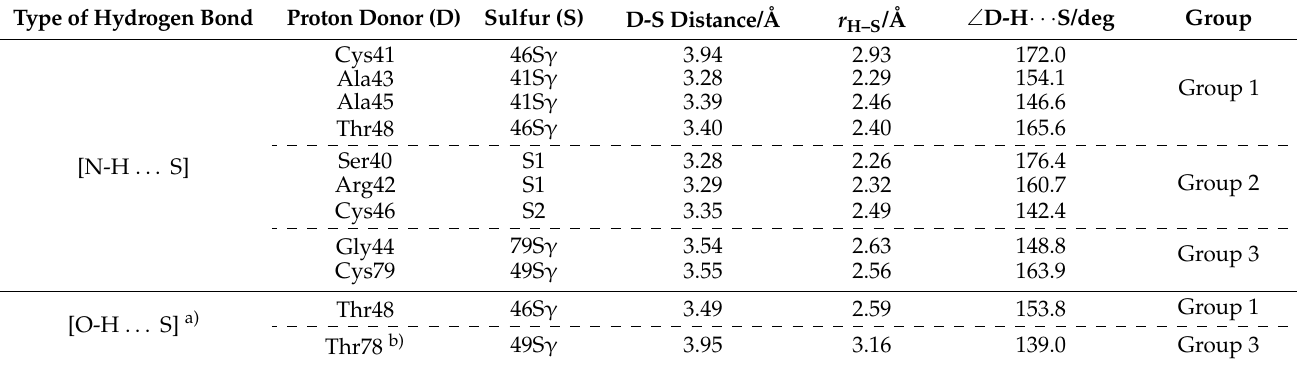
Table 1. Structural parameters about the 11 hydrogen bonds around the active site included in the model structure ( 1 H ). The proton donor (D) is the amino acid residue that provides an N-H (or O-H) bond. The D-S distance is the distance between N and S (or O and S). The geometry of hydrogen atoms is optimized but the position of other atoms is fixed to the X-ray structure. Groups of the hydrogen bonds are classified by attaching sulfur atoms as shown in Figure 2A.